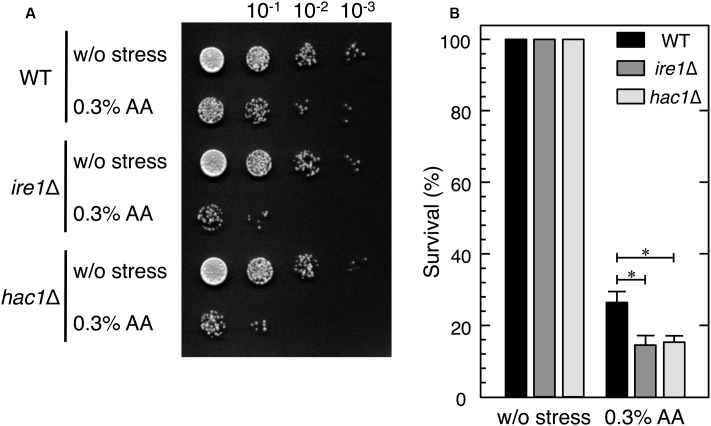
ire1Δ and hac1Δ cells showed higher susceptibility to acetic acid stress than wild-type cells. Exponentially growing cells (OD600 = 0.5) were harvested and resuspended in fresh SD medium to obtain an initial OD600 value of 0.1. To examine their susceptibility to acetic acid, the cells were treated with 0.3% acetic acid (AA) for 5 h. (A) Samples were diluted in 10-1 steps with SD medium, dripped (10 μl) onto SD agar plates, and incubated at 28°C for 2 days. (B) Samples were diluted 500-fold and aliquots (100 μl) were plated onto YPD agar plates. Relative survival rates were calculated as colony-forming units (CFUs). The CFUs of cells before the stress treatment was considered to be 100%. Data are shown as the mean ± standard error (n = 3). ∗P-value < 0.05.